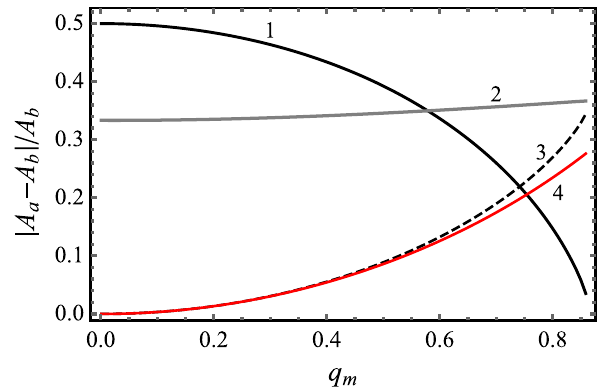
Fig. 4 The plots of relative differences between black hole shadow areas A i ≡ π l 2 where index i stands for Sch w -Schwarzschild, B i Bardeen, NLB non-linear Bardeen, RN Reissner–Nördström . Curve 1: | A